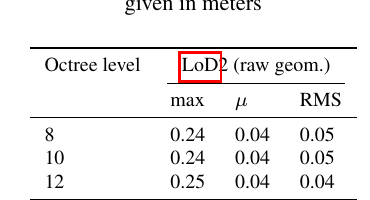
Table 1. Comparison of refined LoD1 building geometries with the geometries of LoD1-3 building models, with all metrics given in meters